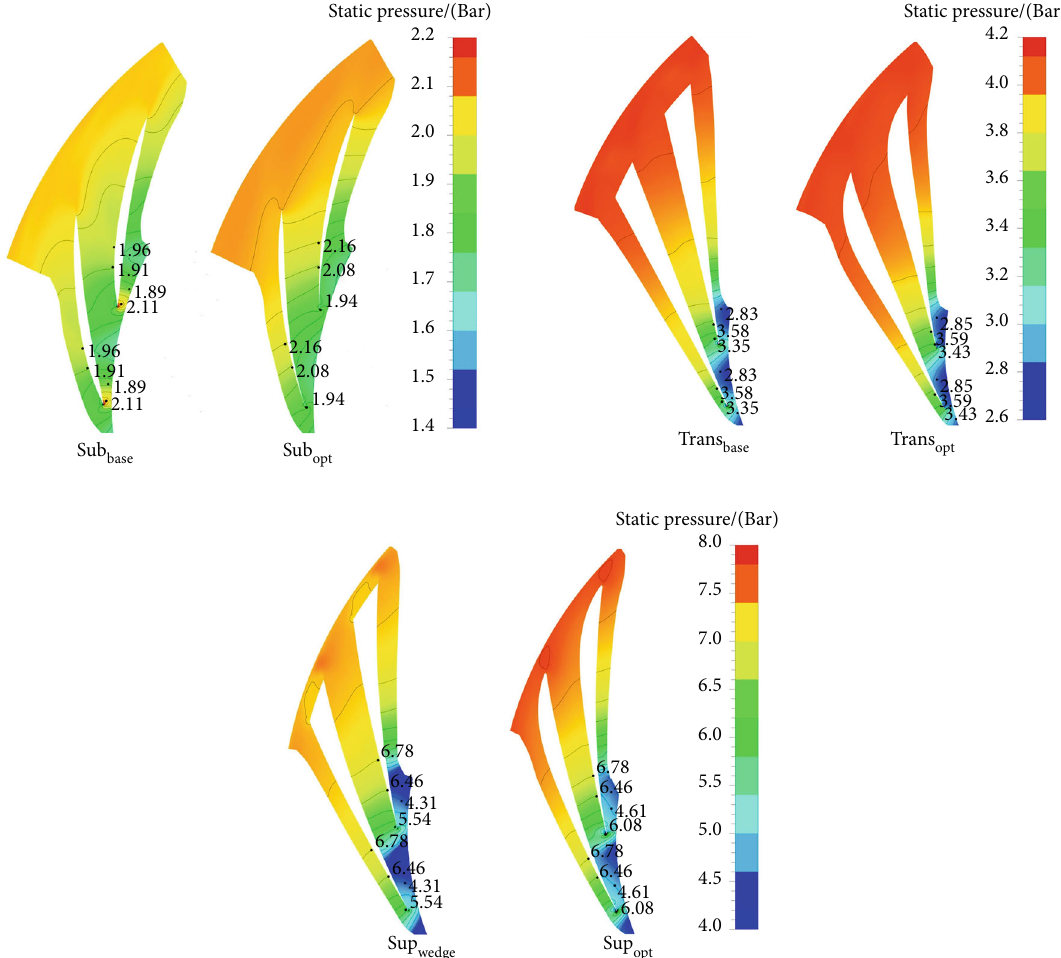
Figure 23: Static pressure contours at 50% span.